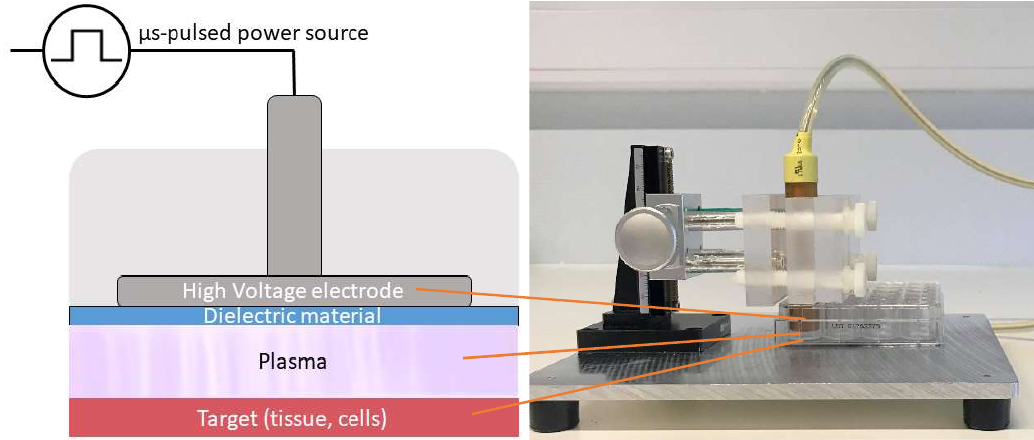
Figure 6. Schematic representation and picture of the FE-DBD used in the experiments.